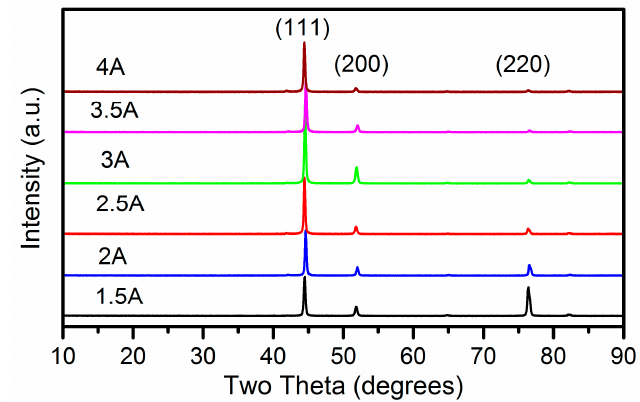
Figure 3. XRD spectra of nc-Ni coatings prepared at different current densities.